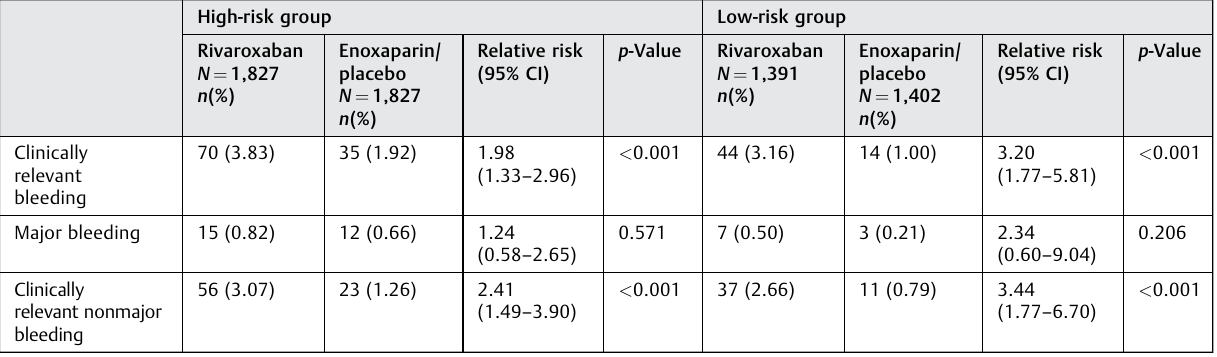
Table 4 Safety endpoints (MAGELLAN subpopulation: safety analysis set, treatment emergent events at day 35) High-risk